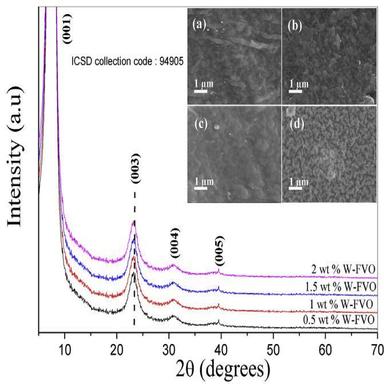
The comparative XRD patterns of the as deposited W-FVO thin films on the quartz substrates .